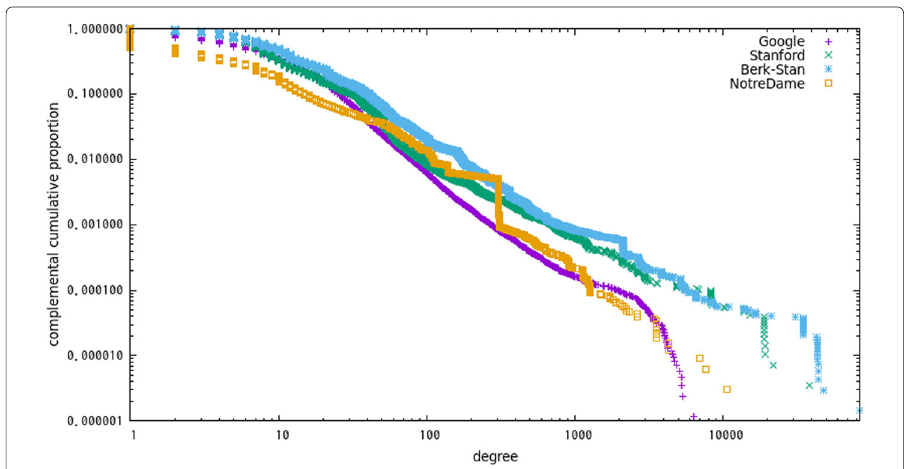
Fig. 2 Degree distribution of four web data. Degree on horizontal axis of logarithmic scale and complementary cumulative proportion on vertical axis of logarithmic scale. Google-web in purple “+”, Stanford in green “x”, Berkeley-Stanford in pale blue “*” and Notre-Dame in orange box